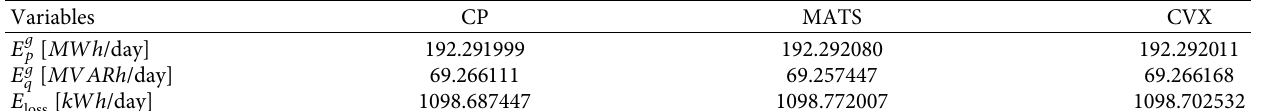
Table 4: Results for simulation 1B.